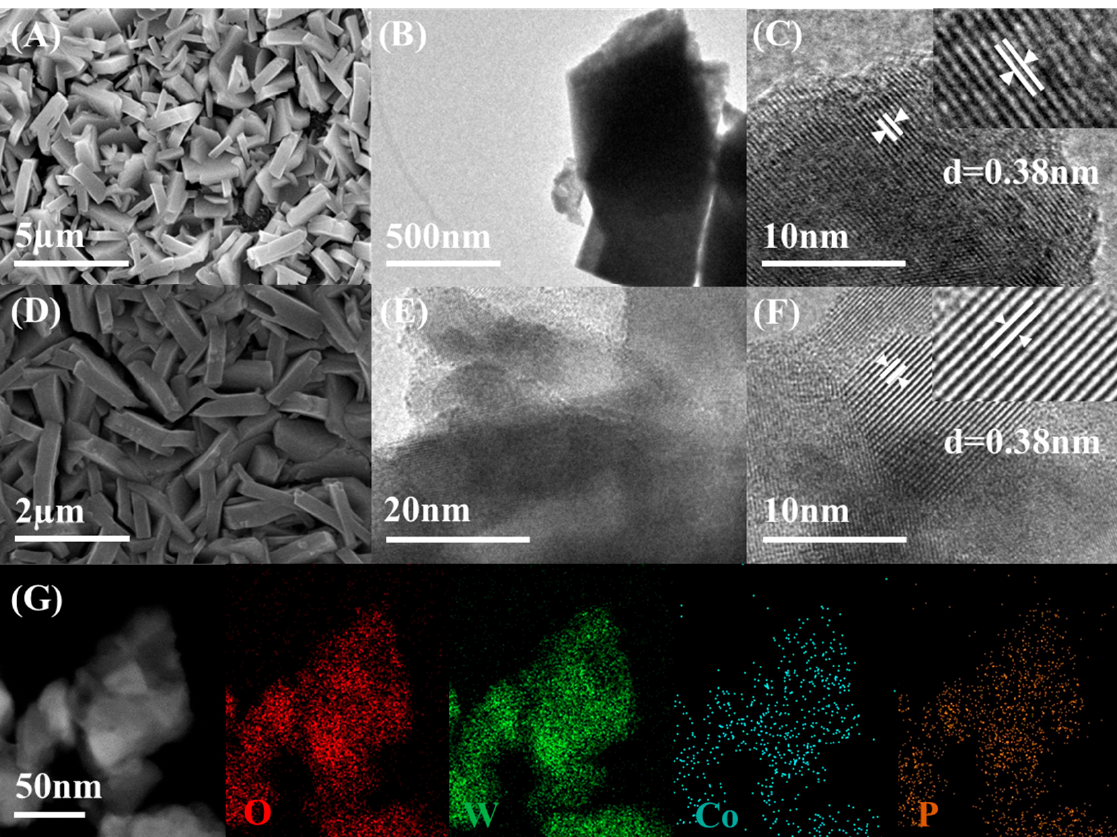
Figure 2. ( A – C ) SEM, TEM, HR-TEM images of WO 3 ; ( D – F ) SEM, HR-TEM images of Co-Pi/WO 3 ; ( G ) EDS elemental mapping images of W, O, P and Co in Co-Pi/WO 3 .